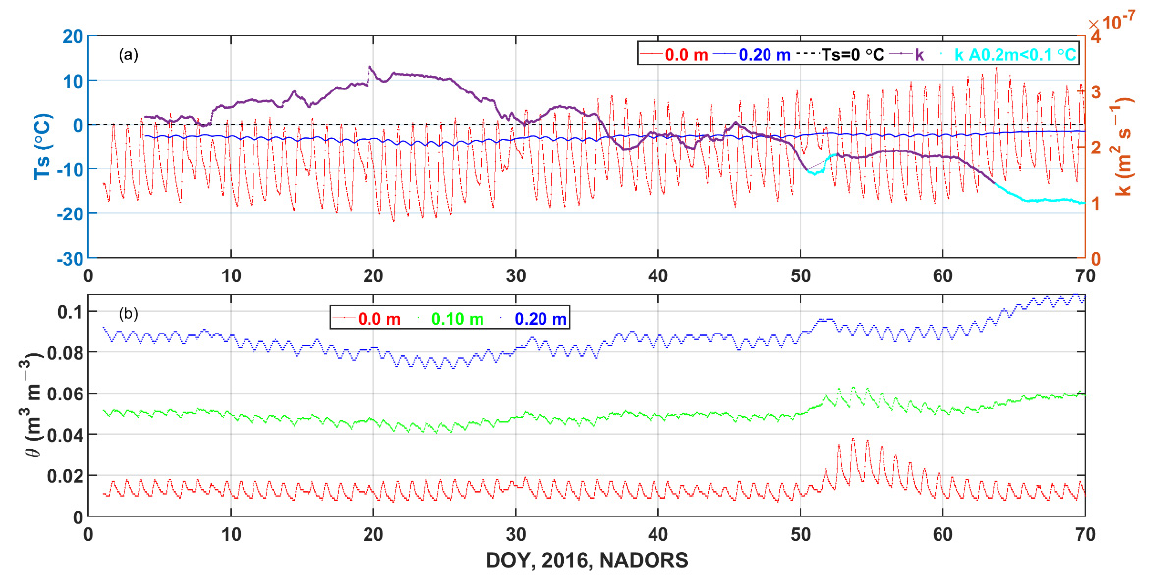
Figure 9. The ( a ) soil temperature (Ts, °C) at the depths of 0.05 m, 0.10 m and 0.20 m, and soil ap- parent thermal diffusivity (k, m 2 s − 1 ), and ( b ) soil moisture ( θ , m 3 m − 3 ) at the depths of 0.05 m, 0.10 m and 0.20 m over DOYs 300–365, 2016, at BJ. The labels of k are marked in cyan when the soil amplitude at the 0.2 m depth is less than 0.5 °C.